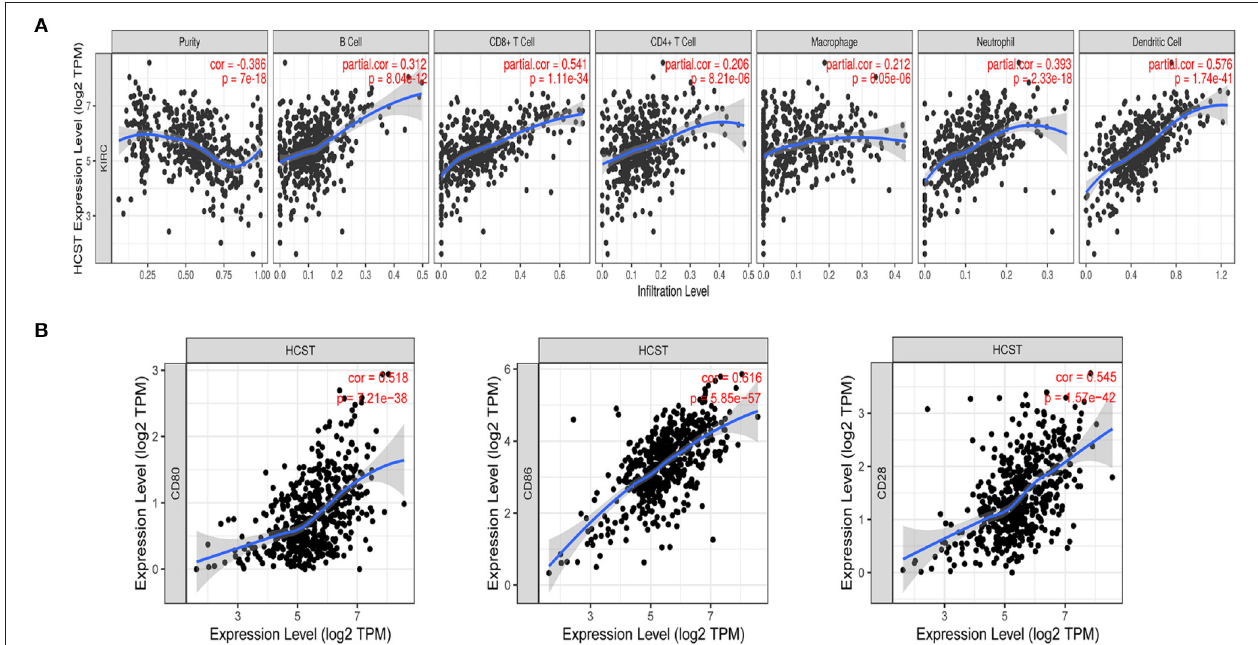
FIGURE 10 | Correlation of HCST with tumor-infiltrating immune cells in ccRCC and the expression of the immune-related genes PD-1. (A) In TIMER, HCST expression was correlated with B cells ( r = 0.312, p = 8.04e − 12), CD8 + T cells, (A) ( r = 0.541, p = 1.11e − 34) and neutrophils ( r = 0.3.93, p = 2.33e − 18), and strongly correlated with DCs ( r = 0.576, p = 1.74e − 41). (B) HCST with CD80, CD86, and CD28 in